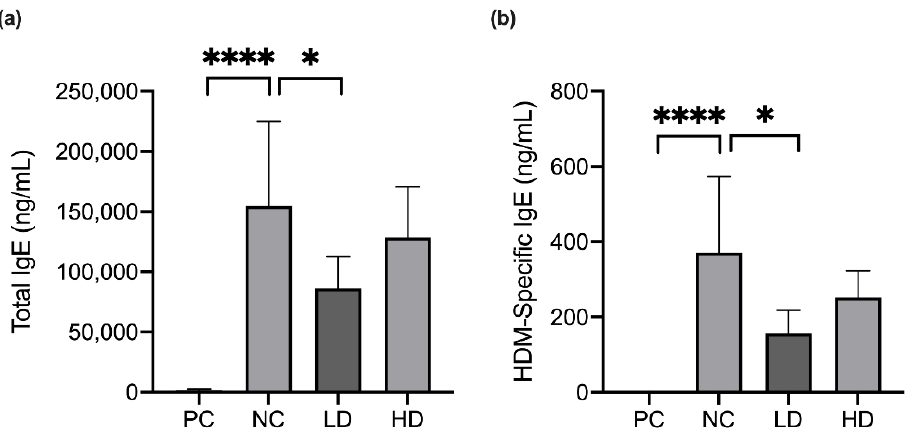
Figure 4. A combination of heat-killed MP01 and MP02 strains decreased the level of HDM-specific IgE ( a , b ) in HDM-extraction induced AD mice. (n = 7–10/group) Data were analyzed using an ANOVA with Dunnett’s multiple comparison tests. * p < 0.05, **** p < 0.0001. Value represents means ± SD.